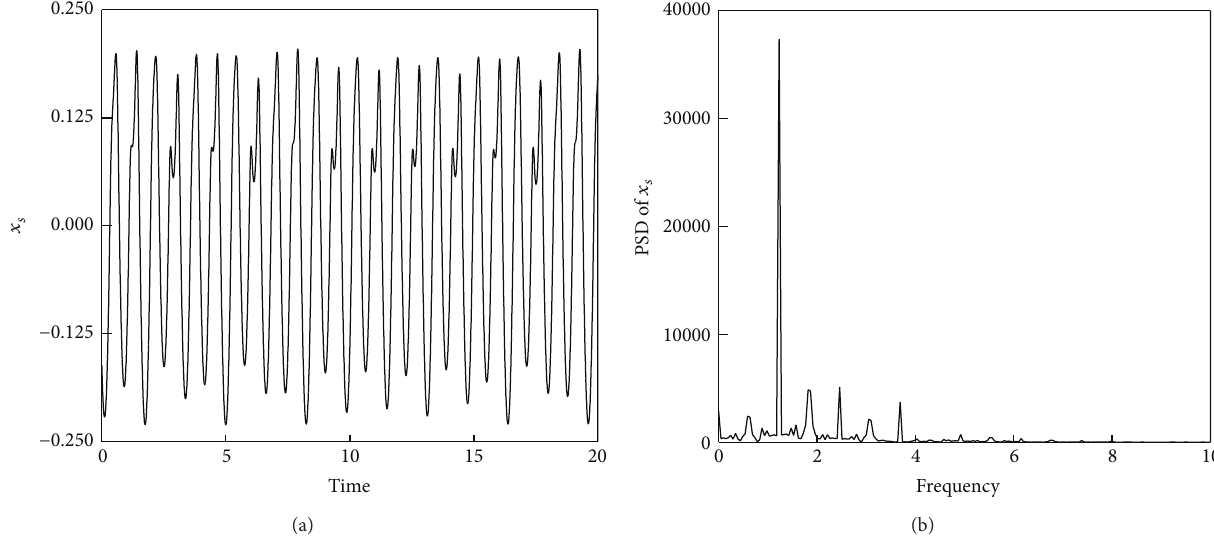
Figure 7: Timing history and PSD of 𝑥 𝑠 for 𝑓 = 2 .4617 Hz, 𝐴 𝑚 = 0 .08 m.